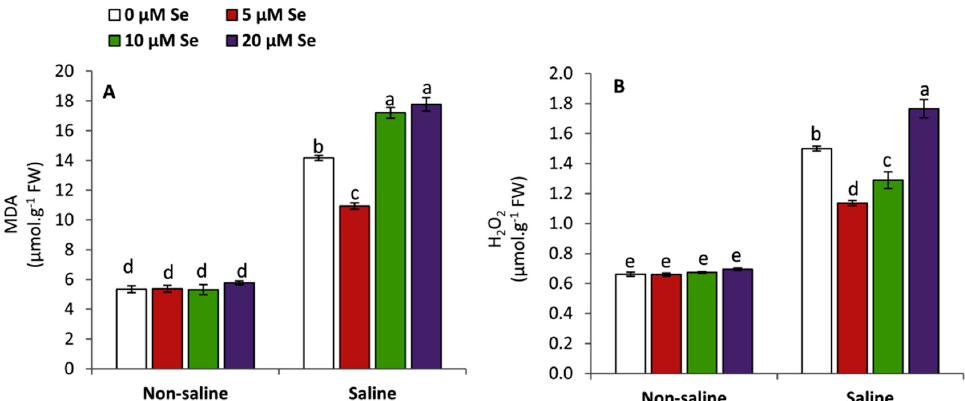
Figure 4. Effect of Se supplementation at 5, 10 and 20 µM on relative water content; malondialdehyde; MDA ( A ) and hydrogen peroxide; H 2 O 2 ( B ) in the leaves of non-stressed and salt-stressed (50 mM NaCl) snap bean seedlings (28 days after sowing). The results are expressed as mean values of three measurements ± SE using Duncan’s multiple range test ( p = 0.05). Different letters indicate significant differences among the treatments.